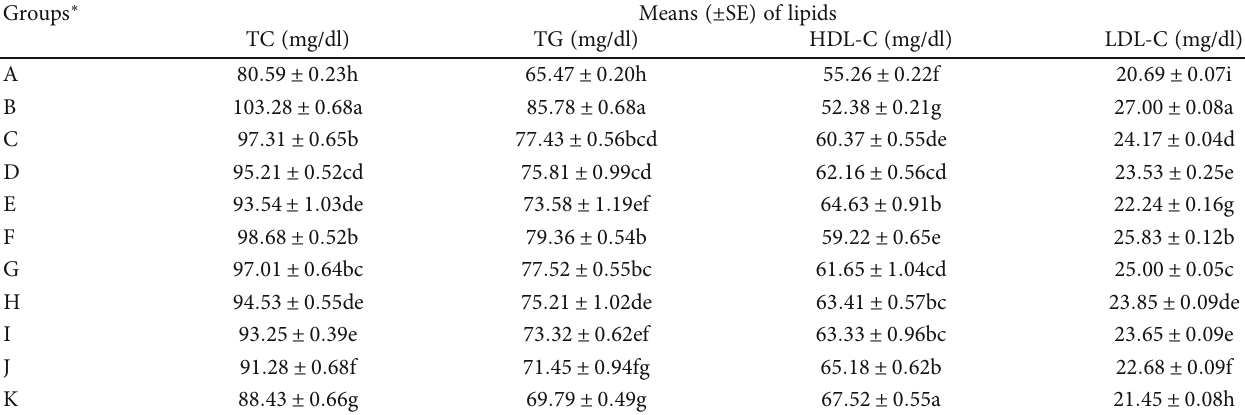
Means sharing same letter in a column are statistically nonsigni fi cant, and means sharing di ff erent letters in a column are statistically signi fi cant ( P > 0 : 05 ). Groups ∗ ; A: negative control (normal rats with normal diet), B: positive control (diabetic rats with normal diet), C: rat groups fed with 5g pumpkin peel powder, D: rat groups fed with 10g pumpkin peel powder, E: rat groups fed with 15g pumpkin peel powder, F: rat groups fed with 5g pumpkin fl esh powder, G: rat groups fed with 10 g pumpkin fl esh powder, H: rat groups fed with 15g pumpkin fl esh powder, I: rat groups fed with 5g pumpkin seed powder, J: rat groups fed with 10g pumpkin seed powder, K: rat groups fed with 15g pumpkin seed